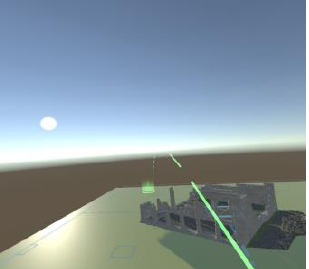
Figure 8: Example of teleporting; the green arc shows the teleport